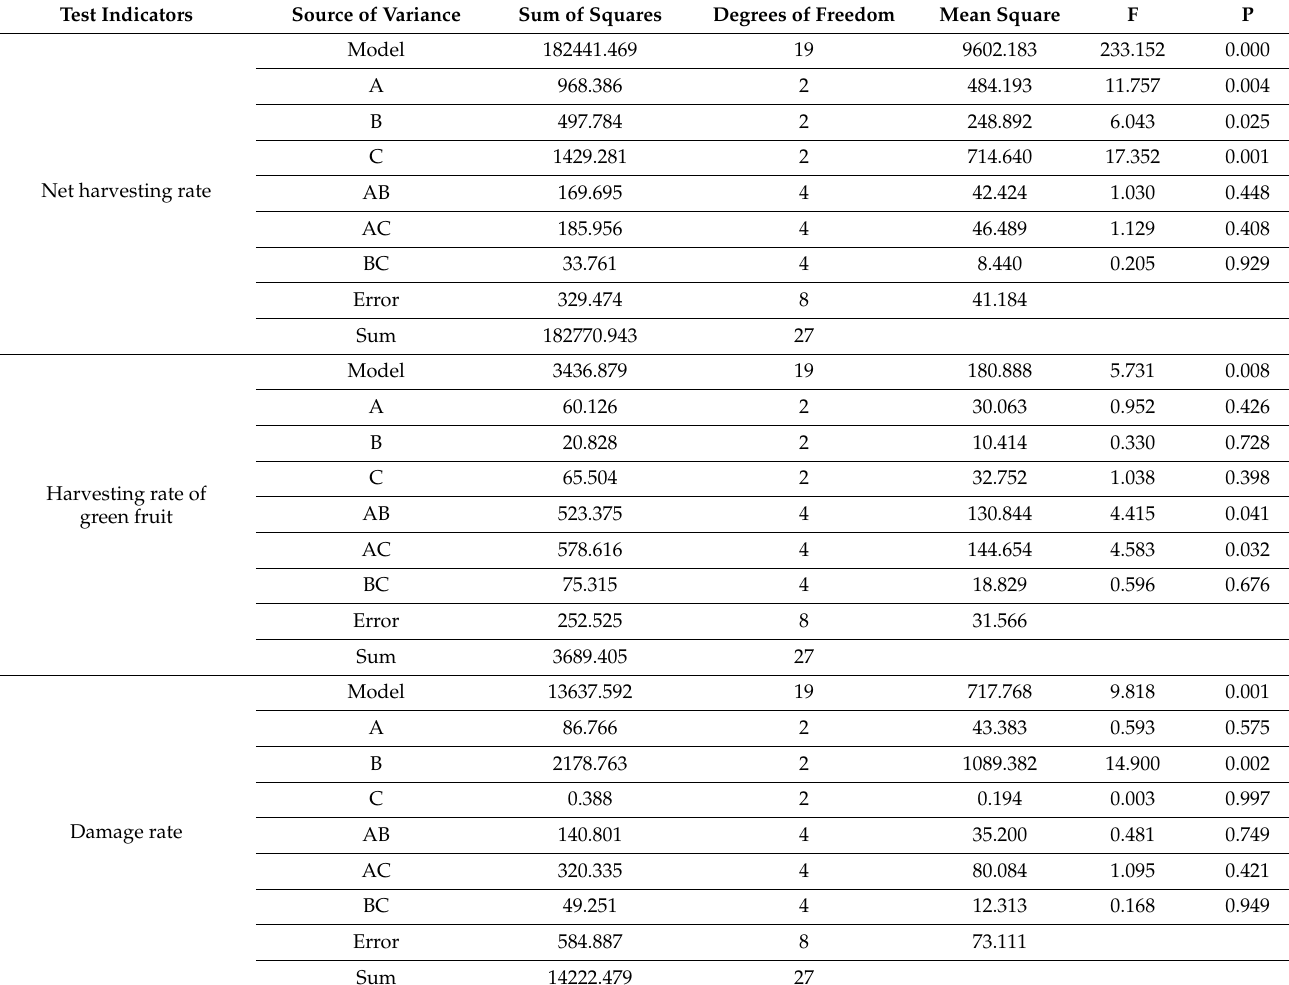
Table 5. Results of analysis of